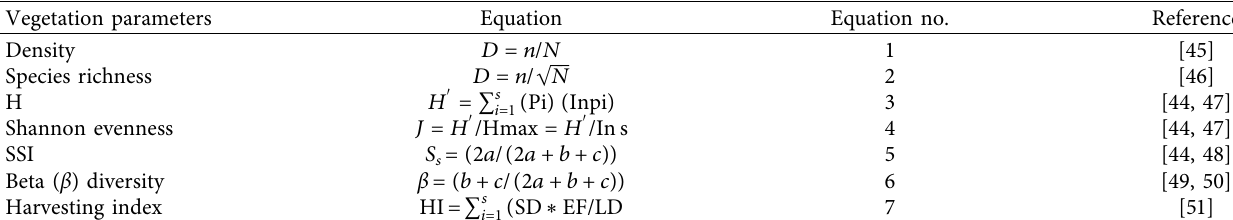
Table 2: List of equations used for calculation of vegetation parameters.